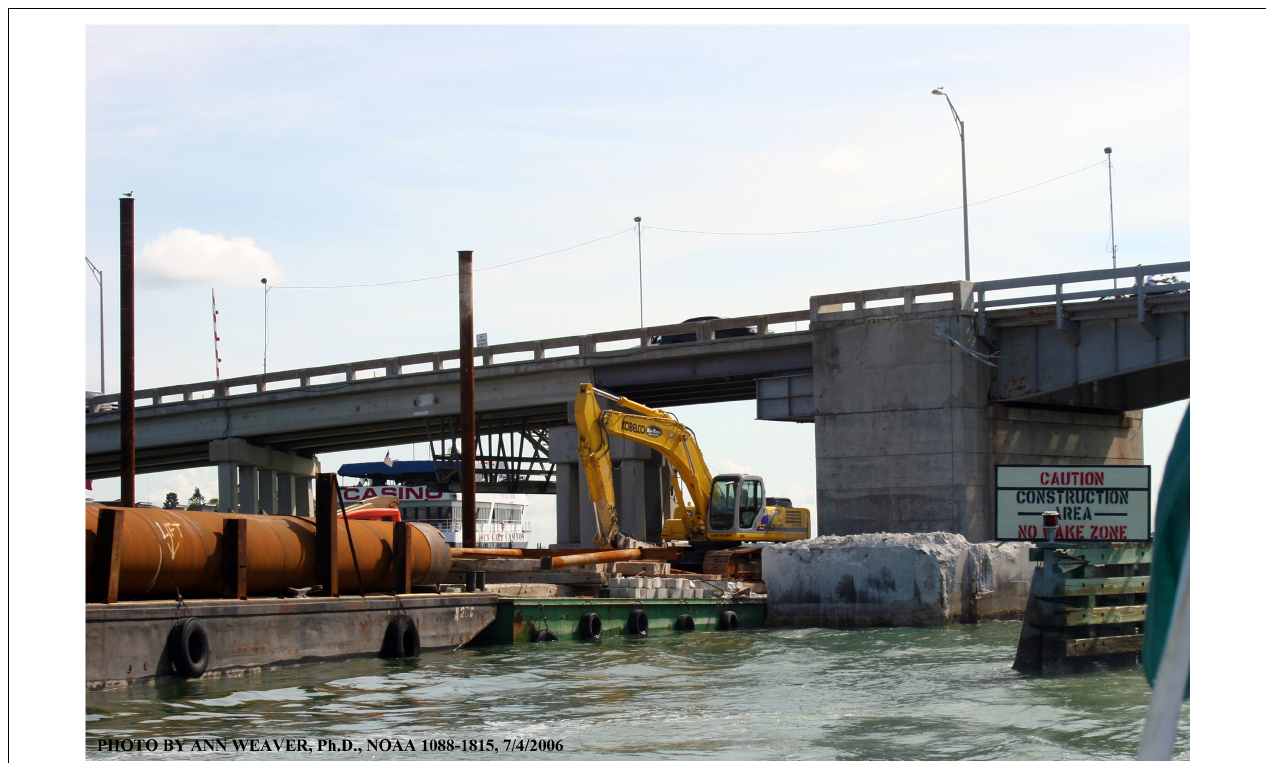
FIGURE 5 | The second set of impacts was mainly related to below-water activity. This included demolition, dismantling, dredging, and removing submerged portions of cement roadway supports and lift towers sunken deep into the sea floor for stability, followed by drilling new pipes of various diameters into the seabed as supports for new traffic lanes and for caissons supporting lift